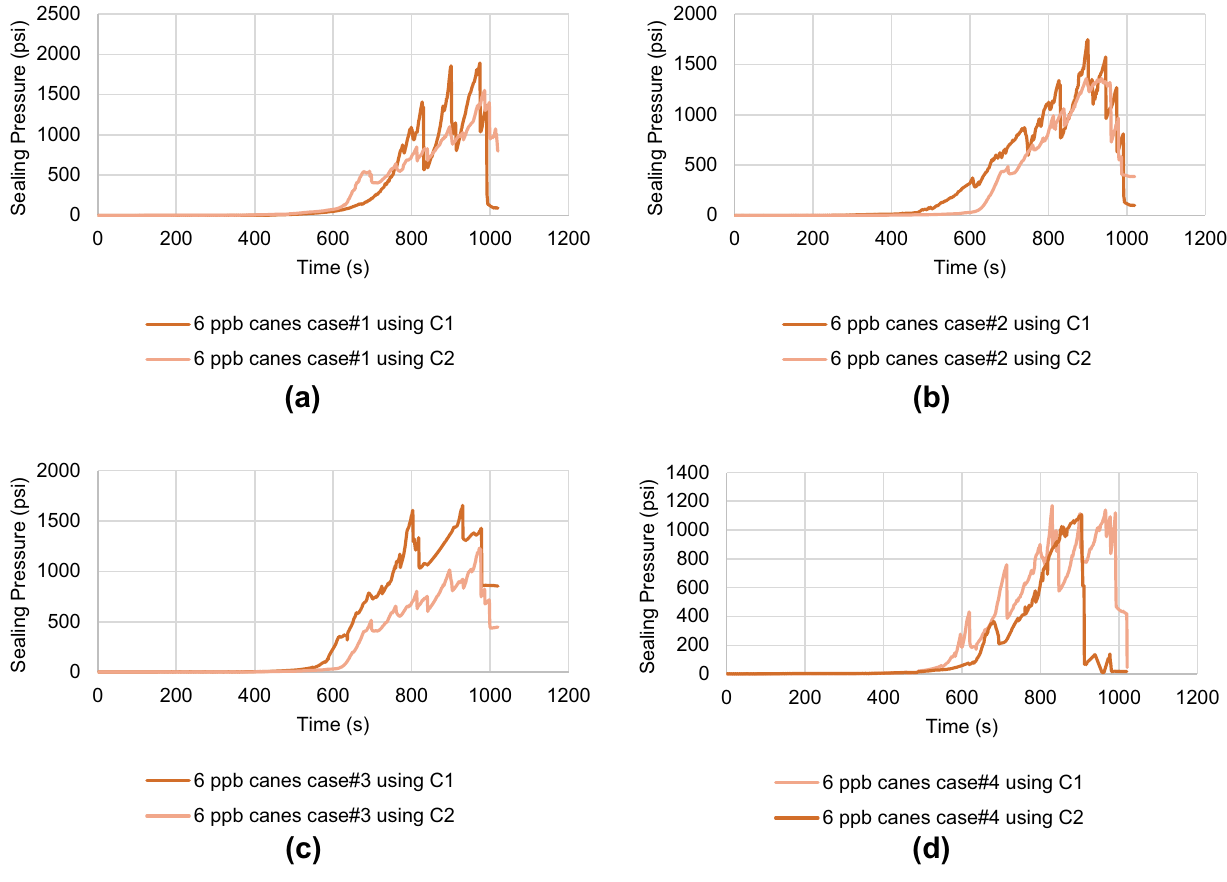
Fig. 16 HPA Pressure versus Time plot for 6 ppb Canes showing maximum sealing pressure at different fracture widths, a case#1, b case#2, c case#3, d